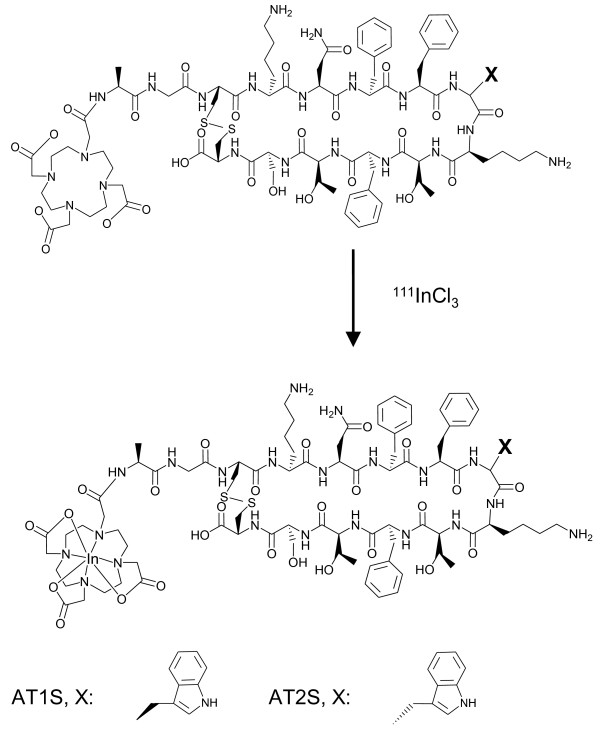
Molecular structure of AT1S/AT2S and their111In analogs.